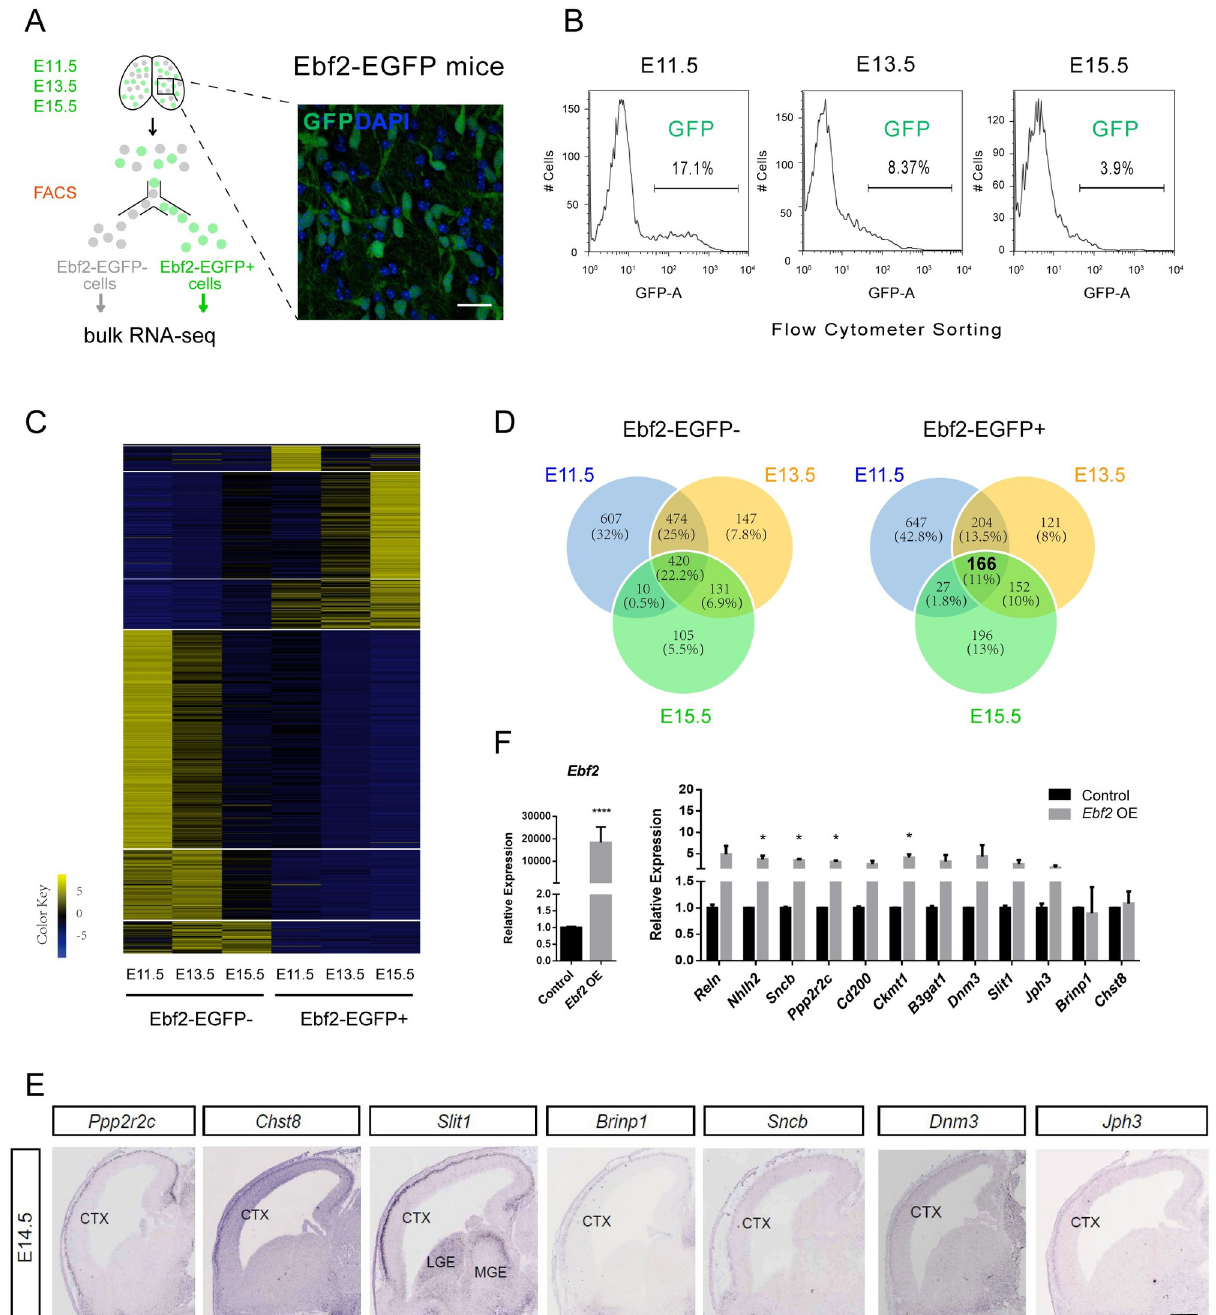
Fig 1. Transcriptome sequencing of Ebf2-EGFP+ and Ebf2-EGFP- cells in the early embryonic stage. (A) Schematic illustration of FACS purification of Ebf2-EGFP+ and Ebf2-EGFP- cells from early embryonic developmental stages E11.5, E13.5 and E15.5, respectively. (B) The percentages of Ebf2-EGFP+ cells collected from FACS at each stage are calculated and shown in the graph. (C) Heatmap of all differential expressed genes (FDR < 0.05) in Ebf2-EGFP+ & Ebf2-EGFP- samples at the three early embryonic stages are shown. (D) Venn diagrams displaying the extent of overlapping between DEGs at the three embryonic stages. (E) Expression of 7 CR-specific coding genes are found to be selectively expressed in cortical layer 1 of E14.5 mouse embryos ( In situ hybridization images from GenePaint.org). Scale bar, 650 μ m. Another CR-specific coding gene Nhlh2 is shown in the S1D Fig. (F) qRT-PCR analysis comparing the expression levels of CR-specific genes in primary neural cell culture assay after virus infection with control (H1) or Ebf2 -overexpression. Data represent mean ± SEM (n = 3 independent experiments, � P < 0.05, Student’s T test).